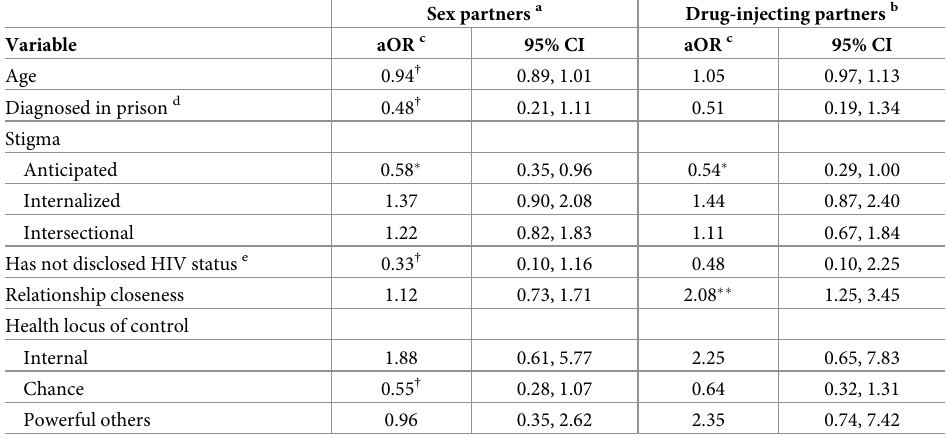
Table 4. Associations with willingness to endorse provider referral to notify sex and drug-injecting partners from multivariate logistic regression. Sex partners a Drug-injecting partners